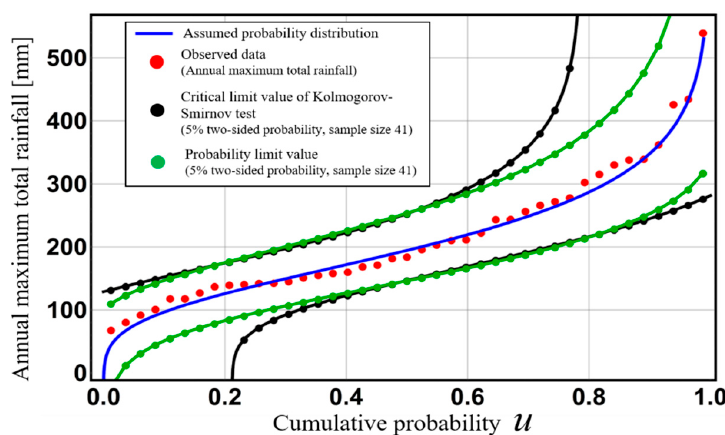
Figure 8. Critical lines of probability limit method test and Kolmogorov–Smirnov test in the case of 5% two-sided probability and sample size 41.